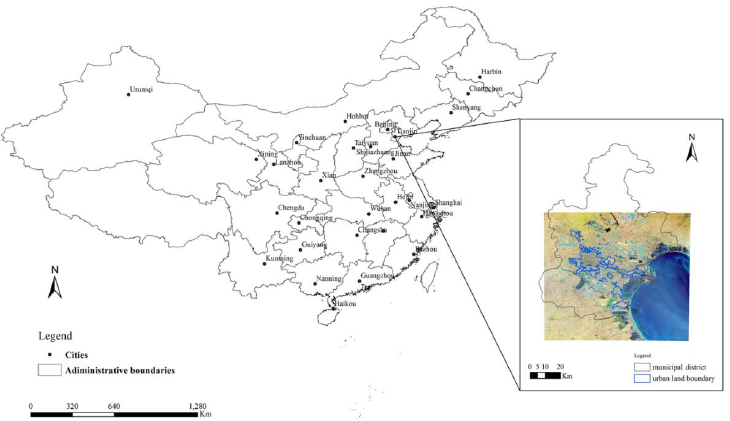
Figure 1. Urban boundary interpretation (Tianjin).